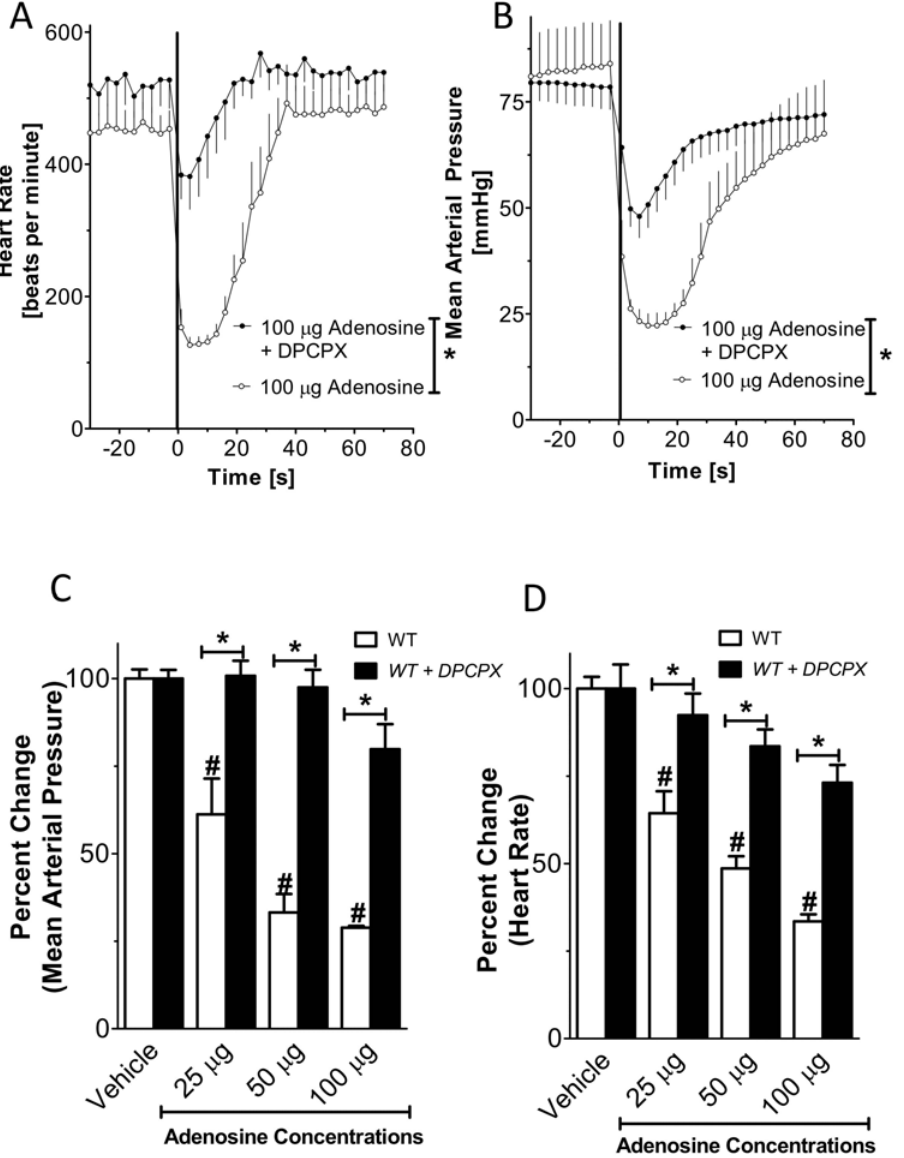
Figure 5. Effect of A1AR antagonist DPCPX on adenosine-induced slowing of the heart-rate. Following insertion of a catheter into the common carotid artery, mean arterial blood pressure and heart rate were measured after injection of vehicle or adenosine at indicated doses (volume of 100 m l). All animals received 1 mg/kg of the A1AR antagonist DPCPX (i.p., 30 min prior to the experimental procedure) or vehicle. (A, B) Heart-rate or mean arterial blood pressure at indicated time points. (C, D) Relative changes of heart-rate or mean arterial blood pressure (n=4, * indicates p , 0.05 compared to DPCPX treatment; # indicates p , 0.05 compared to adenosine-vehicle injection; mean 6 SEM).